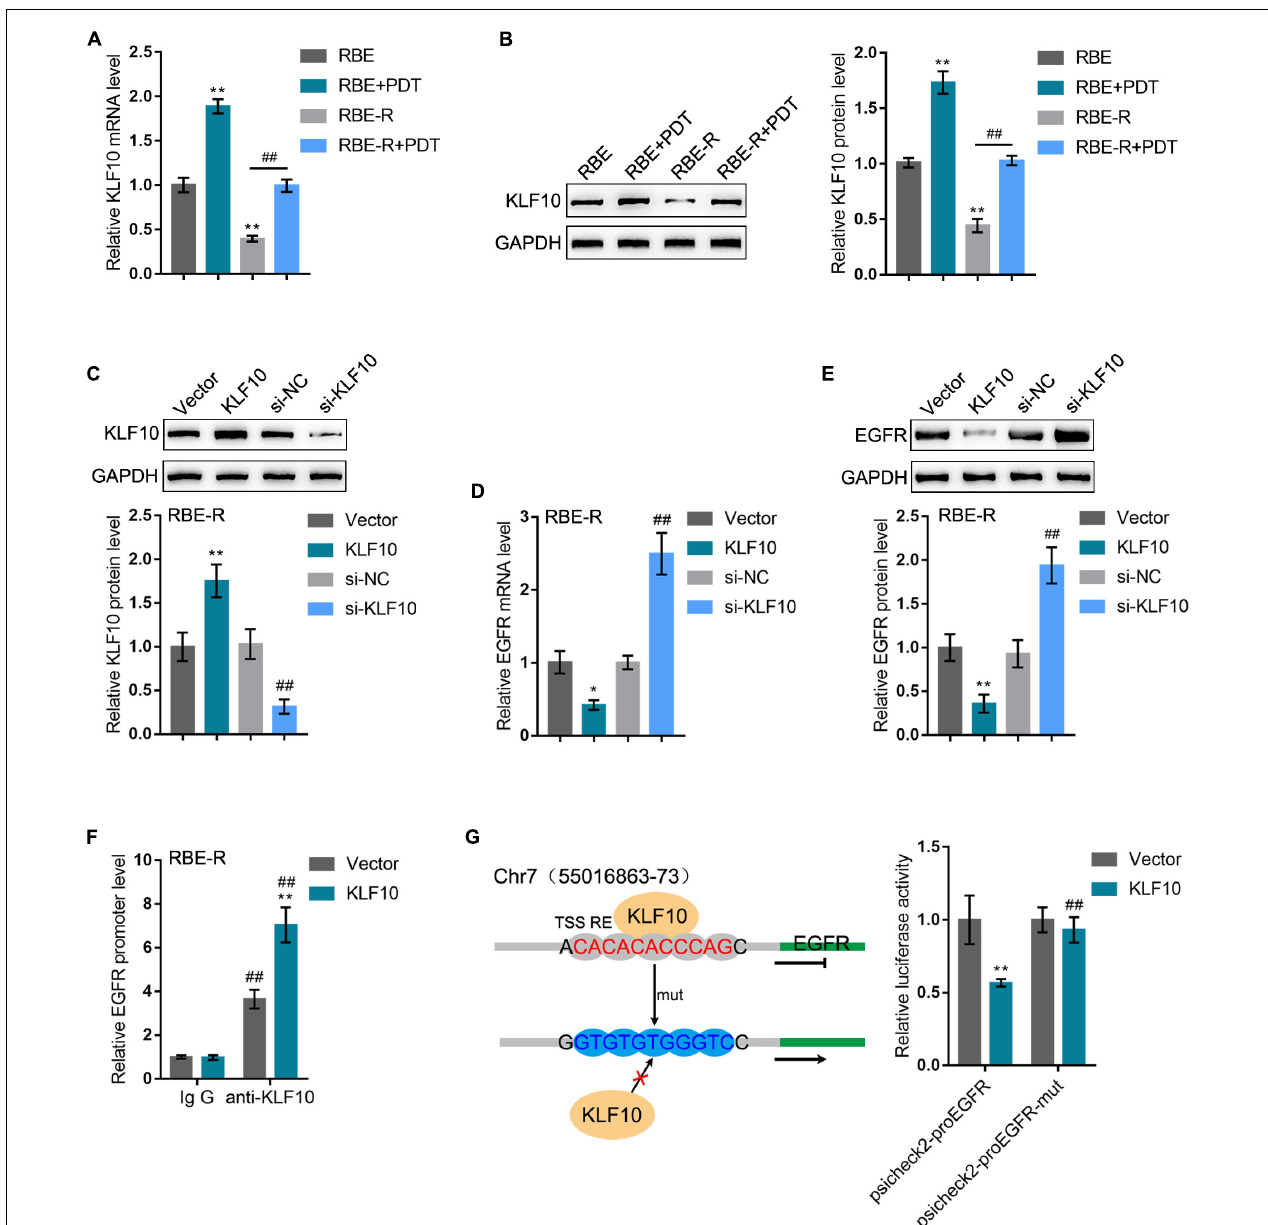
FIGURE 4 | KLF10 inhibits EGFR transcription by binding the promoter region. (A) RBE and RBE-R cells were treated or non-treated with PDT and examined for KLF10 mRNA expression by real-time qPCR. (B) RBE and RBE-R cells were treated or non-treated with PDT and examined for KLF10 protein levels by Immunoblotting. (C) KLF10 overexpression or silencing was achieved in RBE-R cells by transfecting KLF10-overexpressing vector or small interfering RNA targeting KLF10. The transfection efficiency was verified using Immunoblotting. Then, RBE-R cells were transfected with KLF10 or si-KLF10 and examined for the mRNA expression of EGFR by real-time qPCR (D) and the protein levels of EGFR by Immunoblotting (E) . (F) RBE-R cells were transfected with KLF10 or empty vector and ChIP assay was performed using anti-KLF10 or anti-IgG (negative control). The EGFR promoter levels in the immunoprecipitate was examined using real-time qPCR. (G) Wild-type psicheck2-proEGFR and mutant type psicheck2-proEGFR-mut luciferase reporter plasmids were constructed and co-transfected in 293T cells with KLF10 or empty vector. The luciferase activity was examined by a dual-luciferase reporter assay. * P < 0.05, ** P < 0.01, ## P < 0.01.